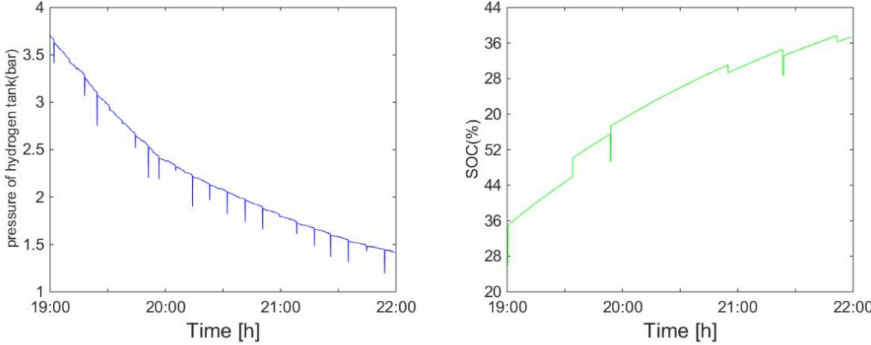
Figure 24. Operation state curves in scenario